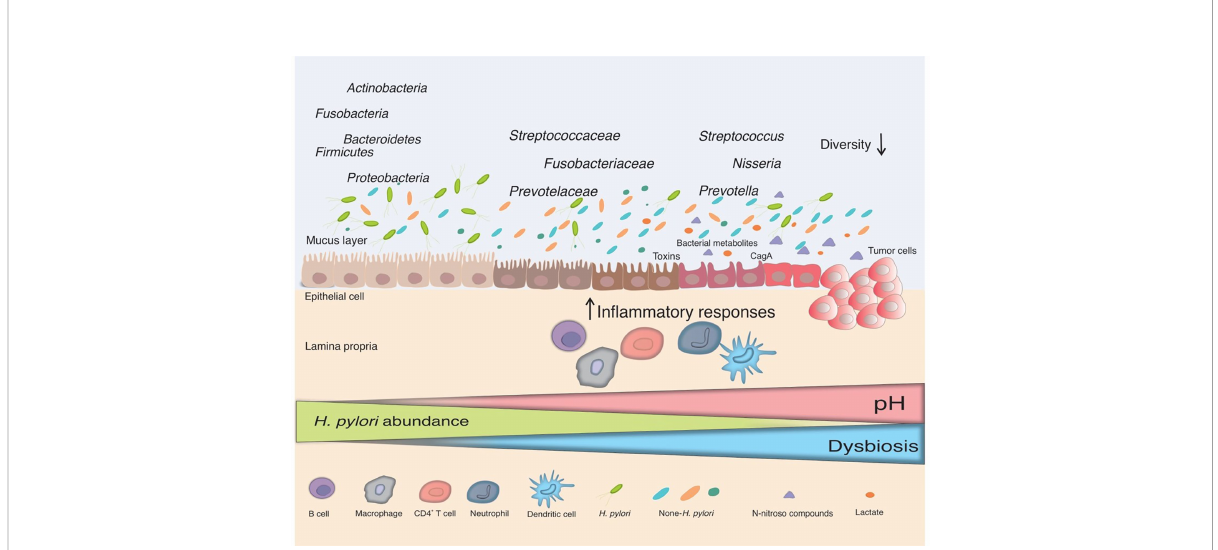
FIGURE 1 The interplay between H. pylori and the gut microbiota. Infection with H. pylori causes and maintains an in fl ammatory response in the gastric mucosa, which leads to the loss of acid-secreting parietal cells and an elevation in gastric pH in certain infected people. H. pylori colonization declines in this changing environment and bacteria from other parts of the gut colonize the gastric niche, resulting in gut dysbiosis. Non- H. pylori bacteria promote gastric carcinogenesis through their own characteristics and microbial metabolites, such as N-nitroso compounds and lactate. The main putative mechanisms include induction of in fl ammatory response, modulation of the immune response, induction of DNA damage, and development of